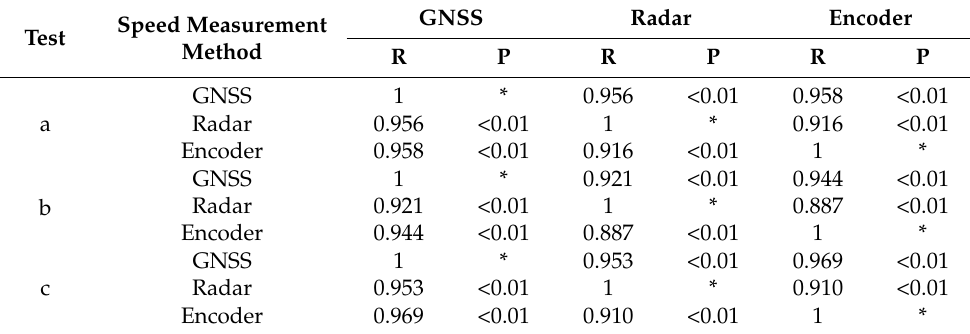
Table 4. Pearson correlation analysis results of the speed monitoring values of the three speed measurement methods.